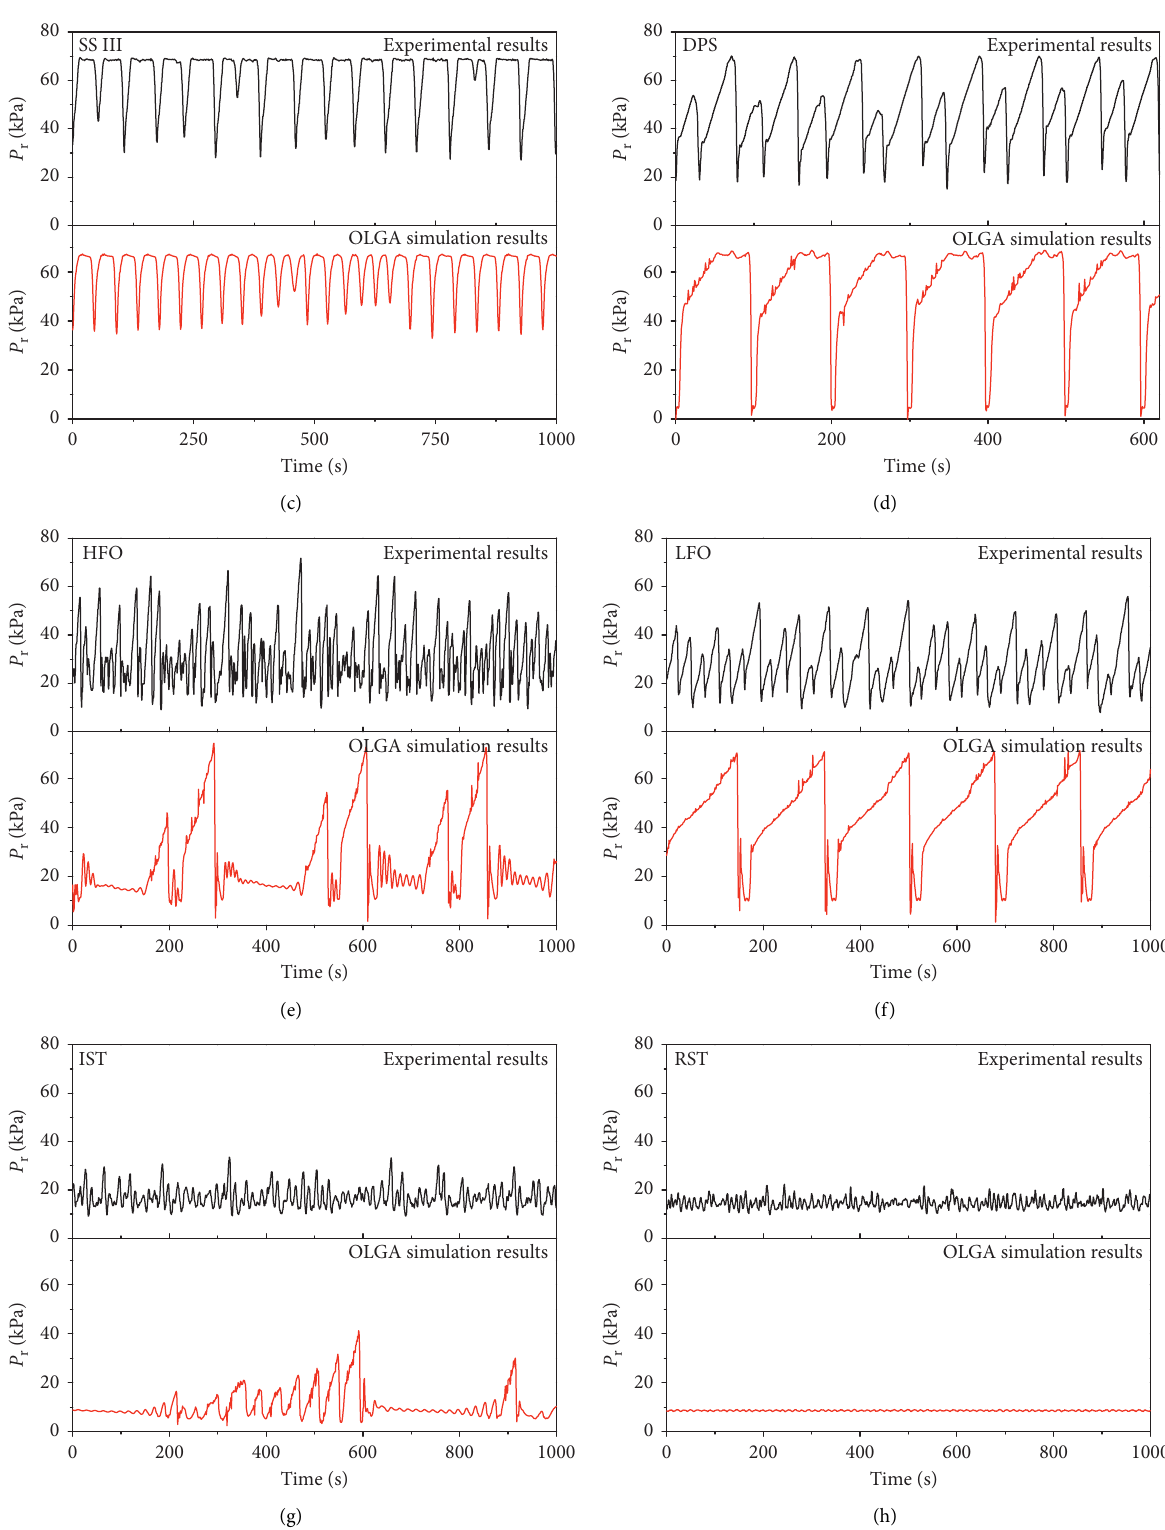
Figure 13: Comparison of OLGA simulation results and experimental results. (a) v � 0.245m/s. (c) v v sg v � 0.843m/s. (g) v sg